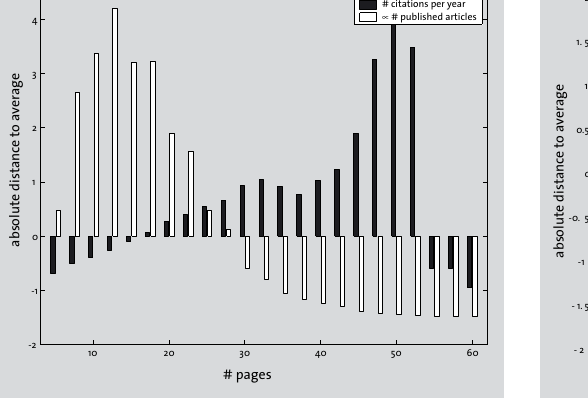
Fig. 1 (left): Mean number of citations per year (CPY) for articles published in the four rheo- logical journals mentioned in the text part versus num-